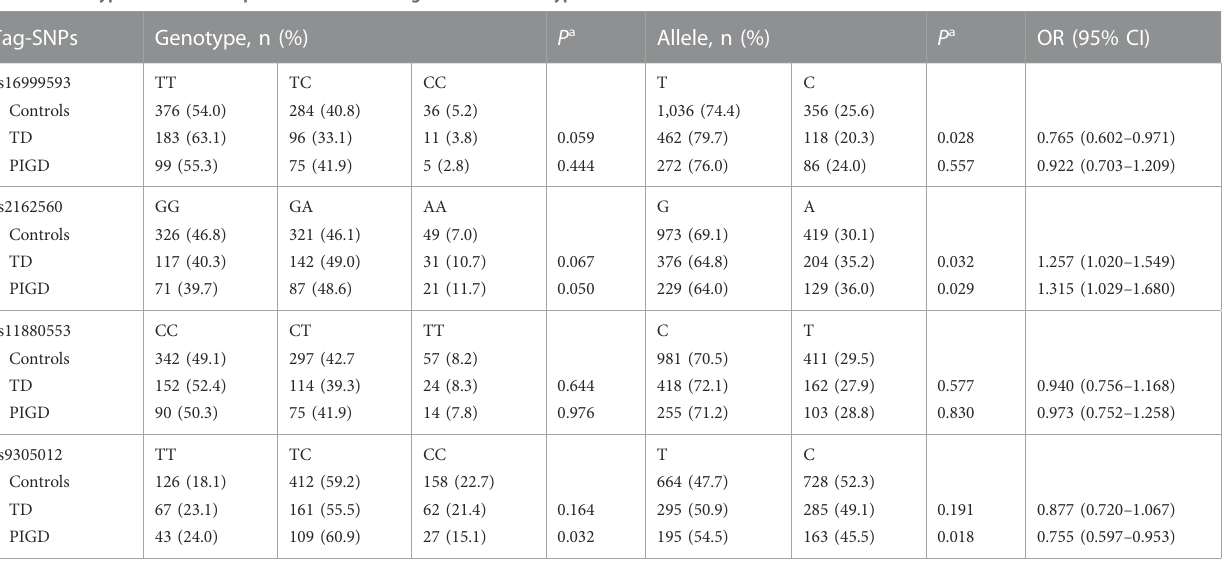
TABLE 6 Haplotype analysis of DNMT1 tag-SNPs in PD subtypes and controls.